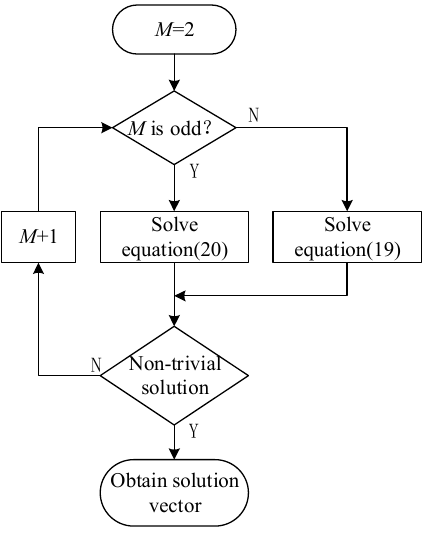
Figure 5. Solution process of filter coefficients.